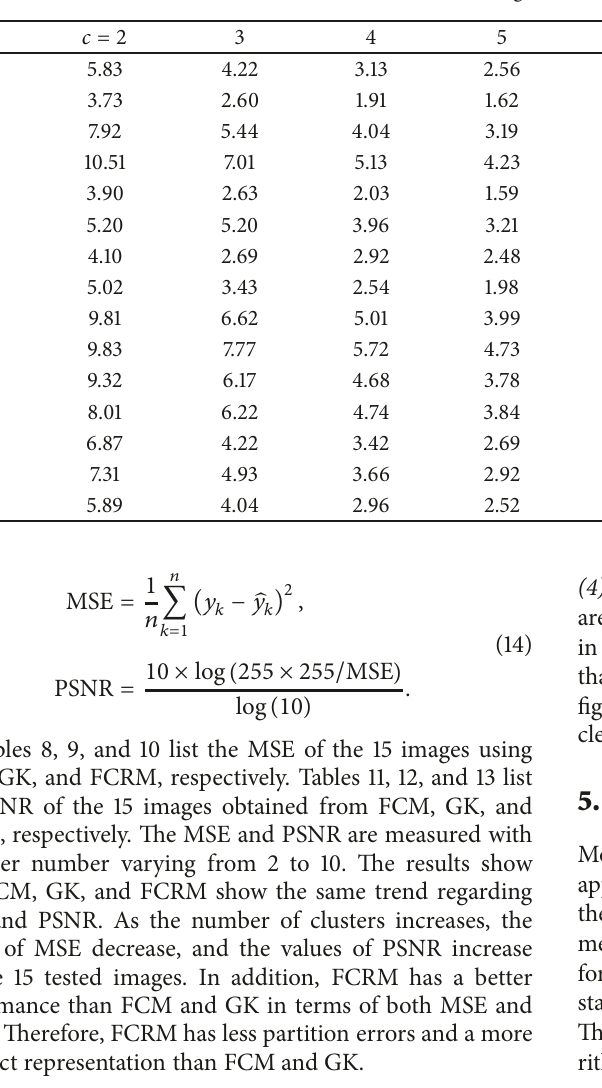
Table 9: MSE ( ×10 3 ) using GK with different cluster